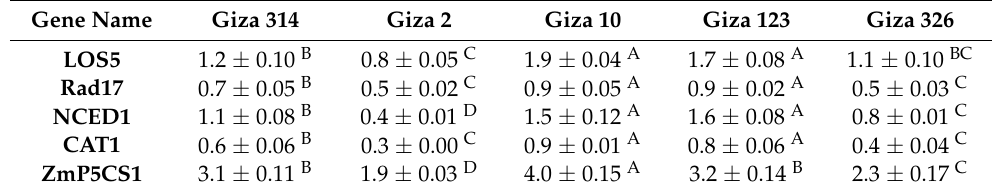
Table 9. Gene expression of LOS5, Rad17, NCED1, CAT1, and ZmP5CS1 stress-responsive genes in five maize genotypes subjected to severe water stress (20 days irrigation interval) at the vegetative stage. Values are means of three replicates ± SD. Different letters within the same row donate significant differences among genotypes based on Tukey’s posthoc HSD test at p = 0.05). Gene Name Giza 314 Giza 2 Giza 10 Giza 123 Giza